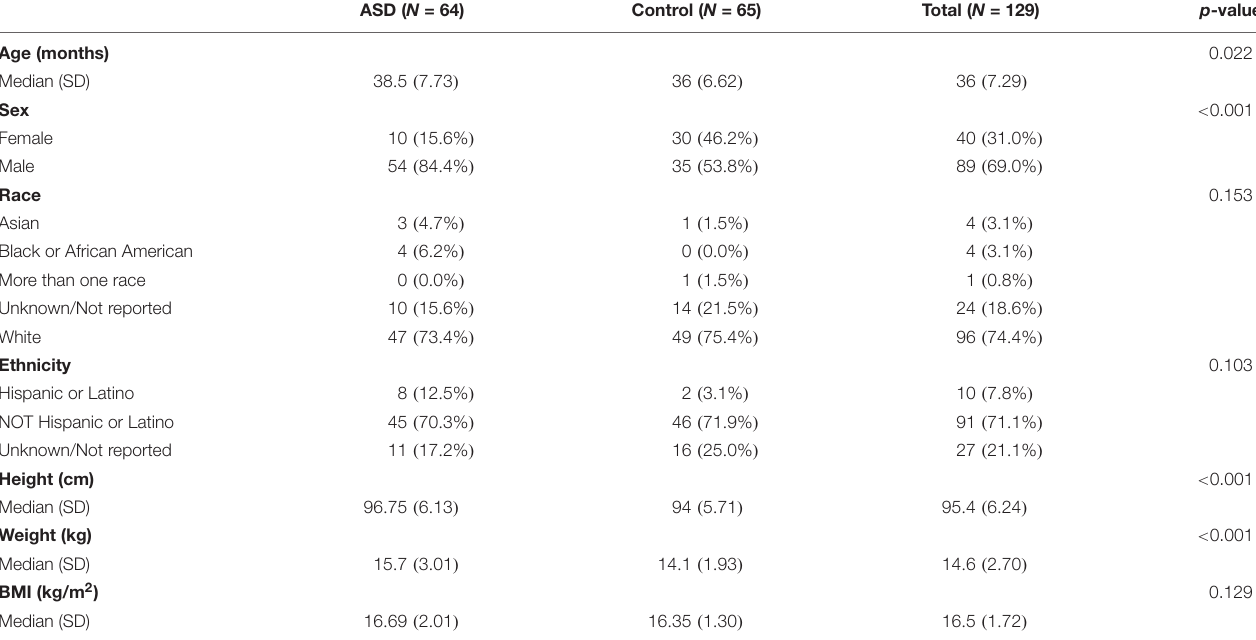
TABLE 2 | Characteristics of case and control study subjects.